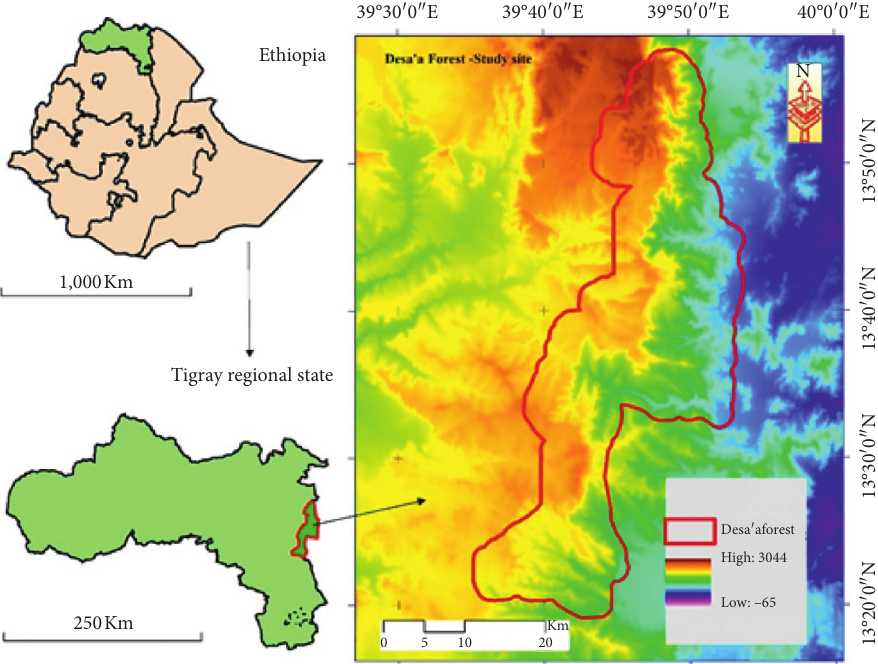
Figure 1: The geographical location of Desa’a forest in Ethiopia.